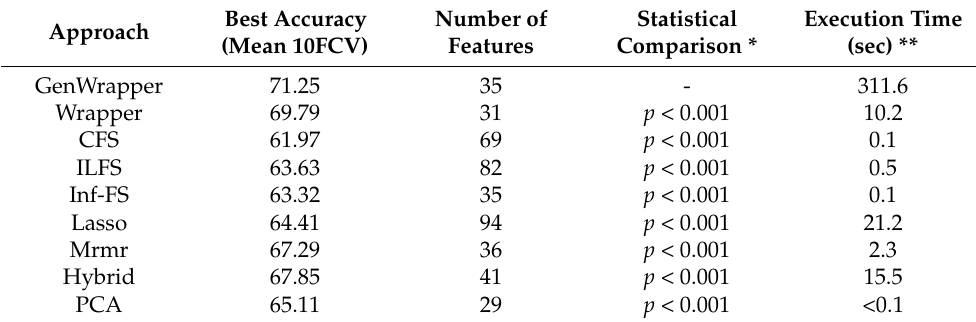
Figure 8. Accuracy (mean 10FCV) with respect to selected features: GenWrapper versus the remaining competing FS techniques. SVM was used for the classification task for all eight FS techniques. Table 5. Best performance (mean 10FCV) achieved by all competing FS techniques employing SVM along with the number of selected features in which this accuracy was